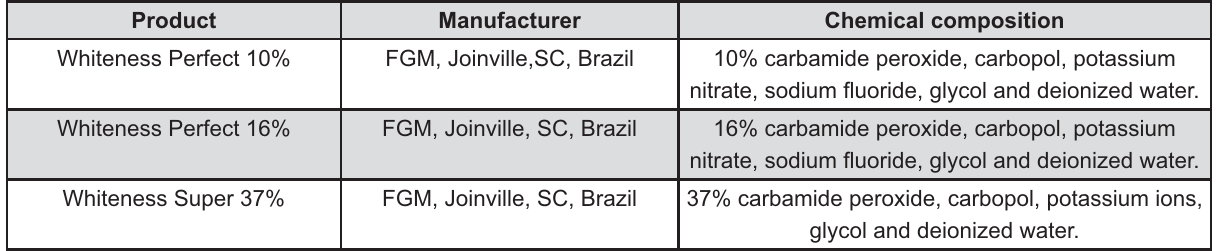
Figure 2- Description of the bleaching agents used in this study Table 1- Tooth shade means and standard deviations (±SD) for the different treatment groups according to the evaluation Treatment groups